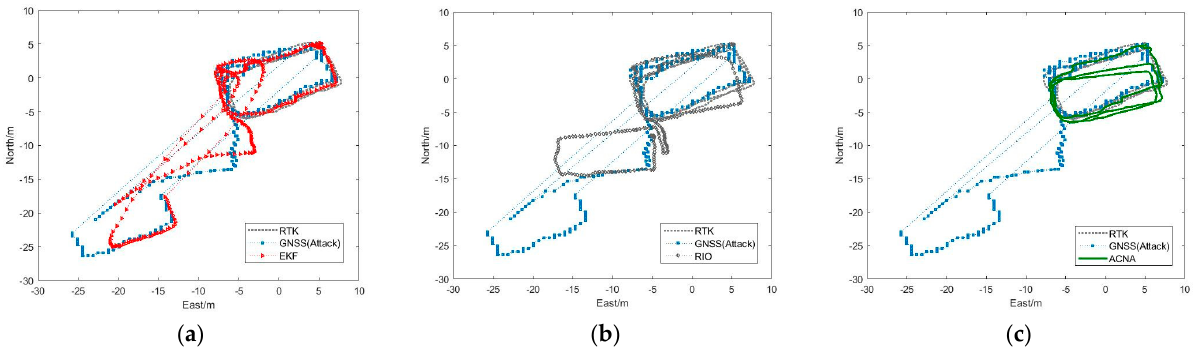
Ψ  : ( a ) EKF; ( b ) RIO; ( c ) ACNA.